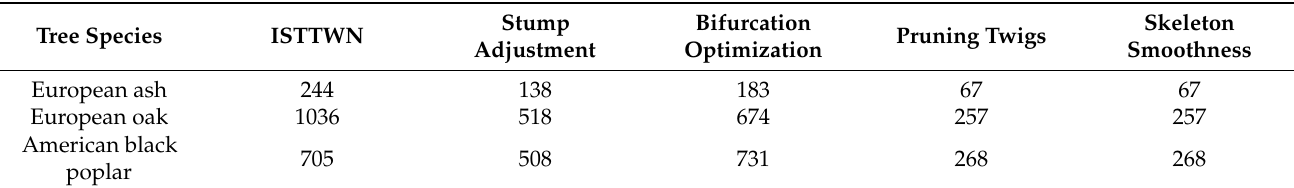
Figure 7. The running time of each part and the change in skeleton lines. Table 2. The change in the identified